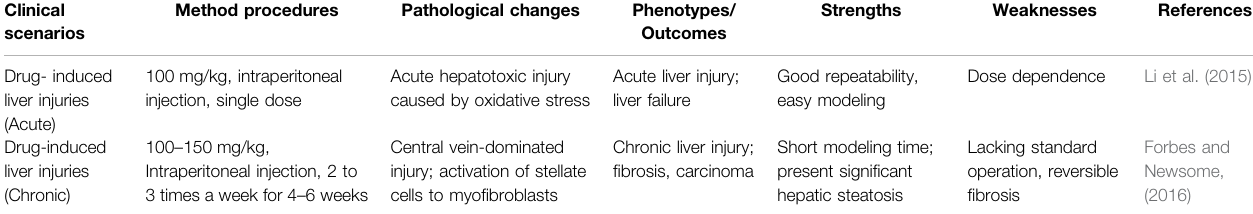
TABLE 2 | Administration of carbon tetrachloride (CCl4) for the liver injury mouse model. Clinical scenarios